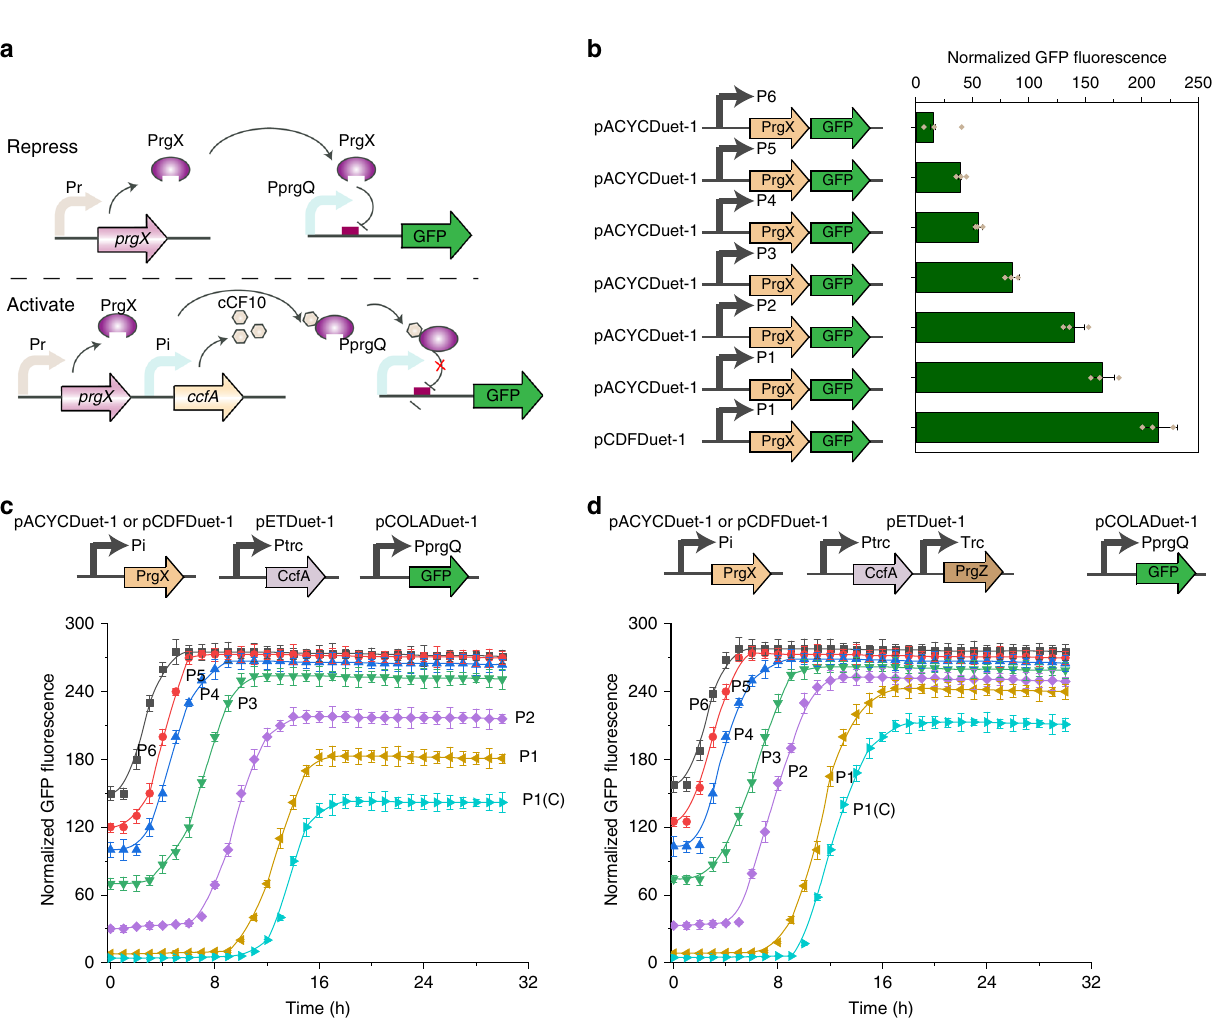
Fig. 4 Decreasing leakiness level of QEX system by protein regulator engineering. a Schematic of QEX-controlled gene expression mechanism. b The demonstration of tunable expression level of PrgX. PrgX protein was GFP tagged to measure its translational output using different promoters and plasmids. Engineered strains were grown in 25 mL of MOPS medium at 30 °C with 220 rpm orbital shaking. Cell fl uorescence and cell density (OD 600 ) were measured after 30 h of culture on a Cytation 3 imaging reader system (BioTek, Winooski, USA). c The impact of different expression levels of PrgX on QEX leakiness level and response function through plate reader experiments. Response promoter PprgQ tagged with GFP was placed on pCOLADuet-1. CcfA was placed on pETDuet-1 under Ptrc constitutive promoter. P1, P2 indicated the expression of PrgX under P1, P2 promoter on pACYCDuet-1, while P1 (C) indicated expression of PrgX under P1 promoter on pCDFDuet-1. d The impact of introducing PrgZ on QEX response function through plate reader experiments. PrgZ was co-expressed with CcfA under Ptrc promoter on the same plasmid. Pre-cultured recombinant cells through overnight incubation at 37 °C were diluted to OD 600 of 0.01 in 96-well plate in 200 μ L of MOPS medium. The culture was conducted on an In fi nite M1000 PRO (Tecan, Switzerland) plate reader at 30 °C. Cell density and fl uorescence were measured every 1 h for 30 h. Values are shown as mean ± SD ( n = 3 biological replicates). Source data are available in the Source data fi